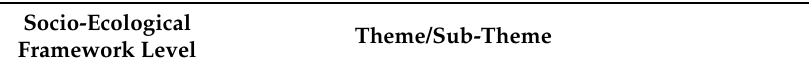
Table 4. Summary of